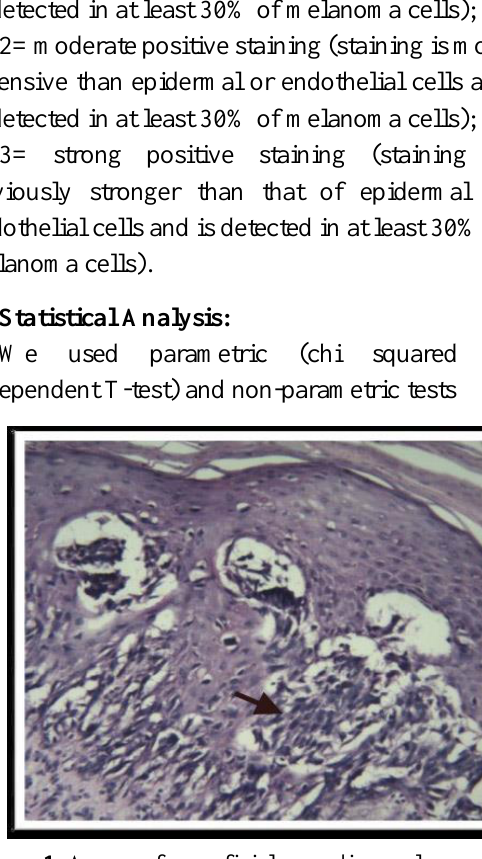
Figure 2. Severe staining for